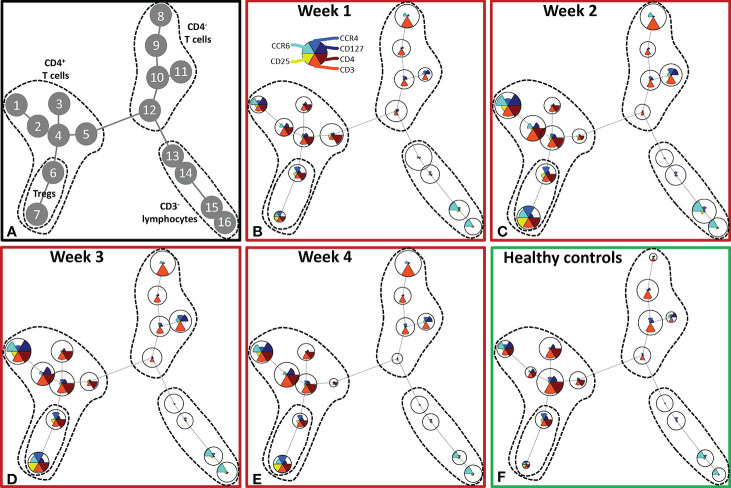
Unsupervised FlowSOM analysis of lymphocyte subtypes after severe burn injury. FlowSOM plots present proportions of populations and the expression of markers that were used in the lymphocyte flow cytometry panel (CD3, CD4, CD25, CD127, CCR4 and CCR6). (A) Cluster structure based on flow cytometry data of 10 healthy controls and 12 burn wound patients that were observed for 4 weeks. The most pronounced subtypes are encircled by dashed lines: CD4+ T cells (nodes 1-7), Tregs (nodes 6, 7), CD4- T cells (nodes 8-12), CD3- lymphocytes (nodes 13-16). FlowSOM plots of: (B) Week 1; (C) Week 2; (D) Week 3; (E) Week 4 after burn; (F) Healthy controls.